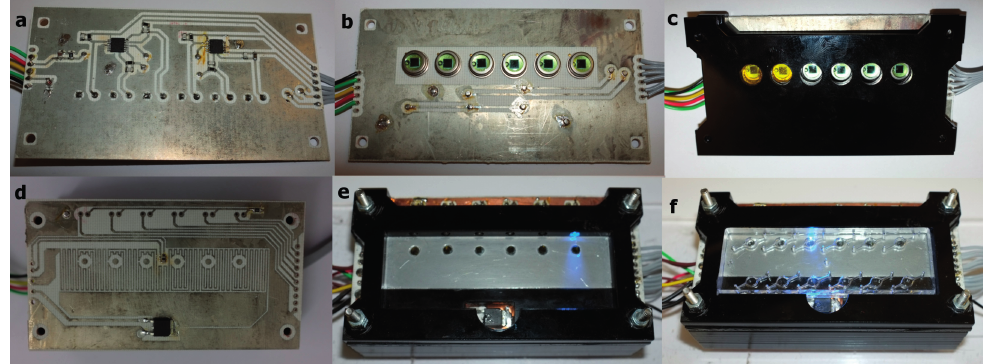
Figure 2. Layered structure of the device. ( a ) Underside of photodiode printed circuit board (PCB) layer containing filtered op-amp circuit; ( b ) Upper side of photodiode PCB